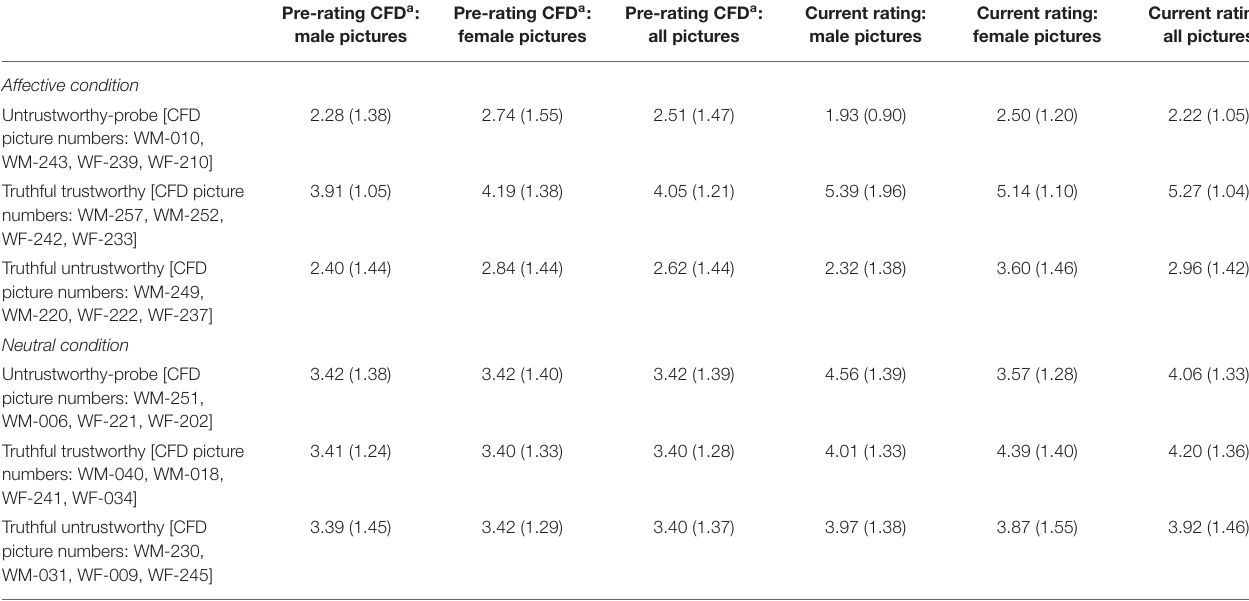
TABLE 1 | Assignment of stimuli to picture types and their rated